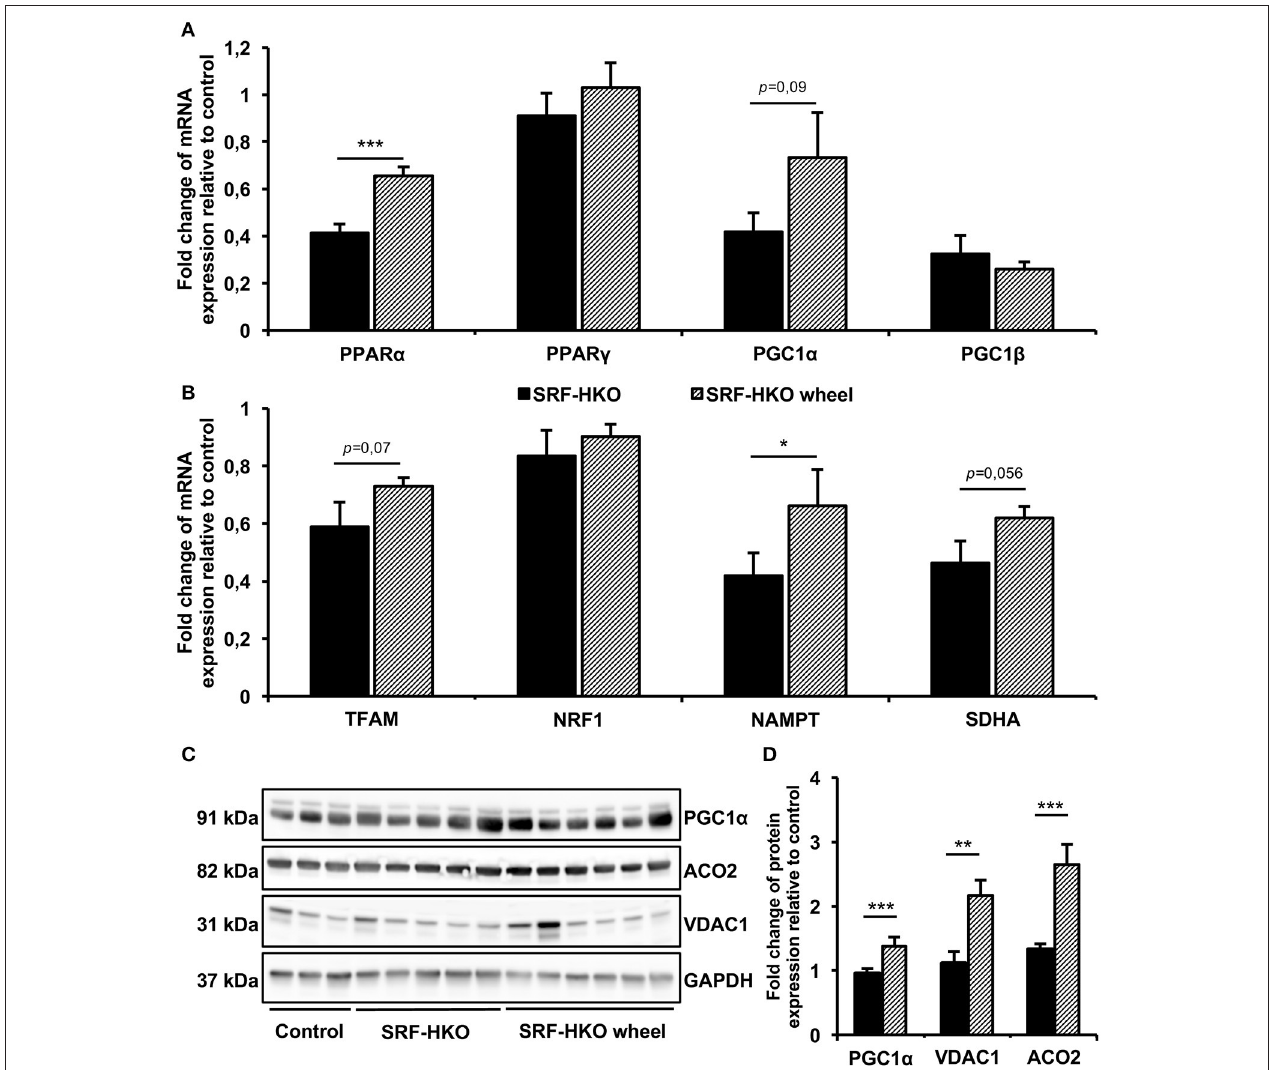
FIGURE 3 | Real-time PCR (A,B) and Western blot analysis (C,D) of mitochondrial biogenesis and selected energetic pathways. (A,B) Relative quantification by real-time PCR of peroxysome proliferator-activated receptors alpha and gamma (PPAR α / γ ), PPAR gamma coactivators-1 alpha and beta (PGC1 α / β ), Transcription factor of activated mitochondria (TFAM), nuclear respiratory factor 1 (NRF1), nicotinamide phosphoribosyltransferase (NAMPT) and succinate deshydrogenase complex subunit (SDHA) mRNA levels in myocardial tissue. Results are presented in-terms of a fold change to control after normalizing with Hmbs mRNA. The control mice value is set at 1.0. (C,D) Western blot analysis (C) and histogram representation (D) of PGC1 α , mitochondrial Aconitase (ACO2) and Voltage-Dependent Anion-selective Channel 1 (VDAC1) proteins quantification. Results are presented as a fold change to control after normalizing with GAPDH protein. The control mice value is set at 1.0. Results are expressed as mean values ± SEM. * p < 0.05, ** p < 0.01, *** p <